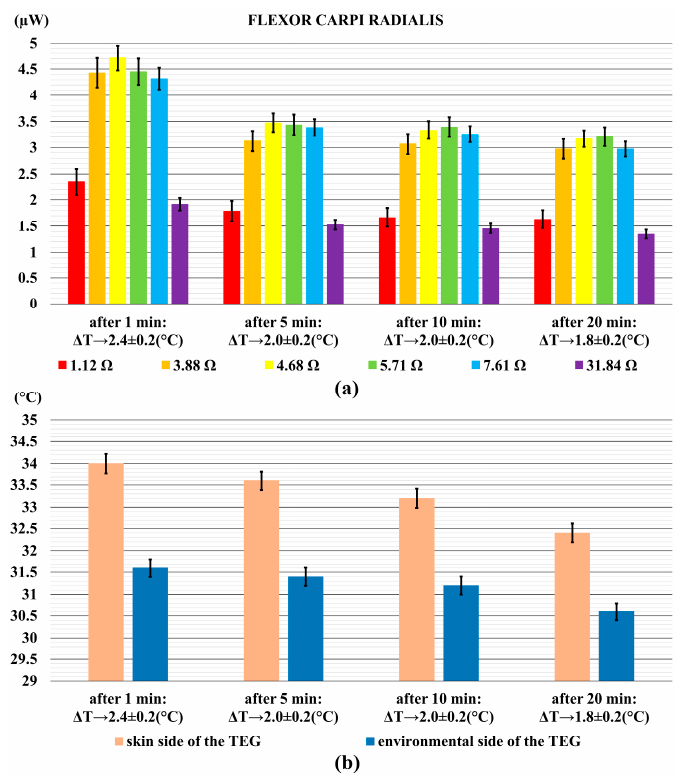
Figure 5. The power output generated by the TEG on the forearm, (flexor carpi radialis) ( a ); and the relative temperature difference ( b ). Error bars represent standard deviations.